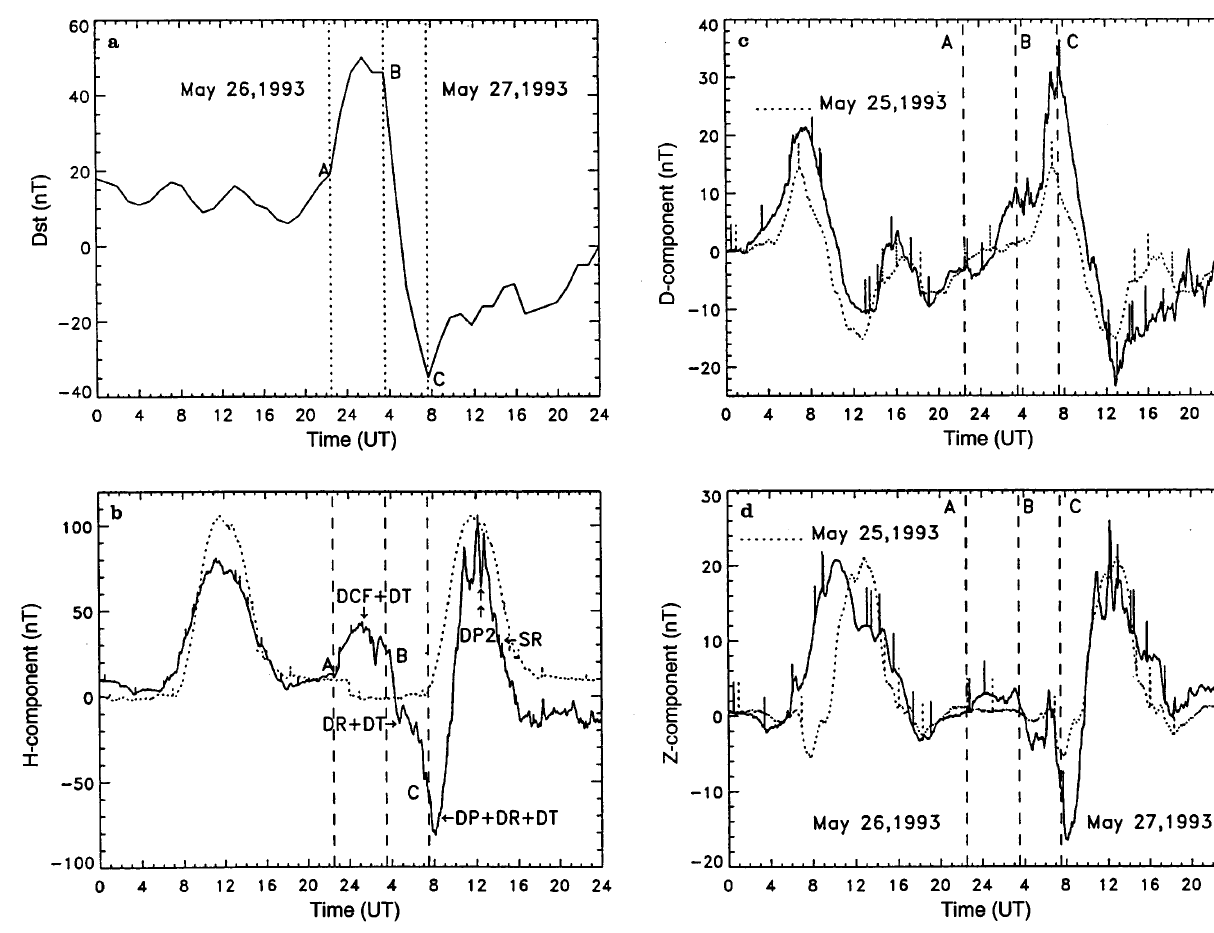
Fig. 1. a Equatorial Dst time variations on 26 and 27 May 1993. The letters A, B, and C indicate, respectively, the time of the storm onset (the SSC), the beginning of the main phase and the recovery phase. b–d Synopsis diagram of H -, D - and Z -component amplitude